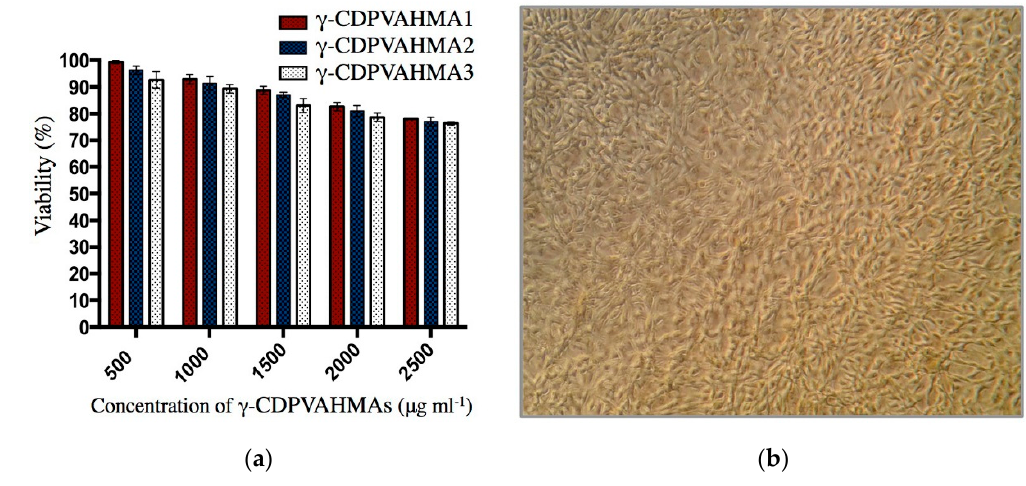
Figure 13. ( a ) Ratio (%) of cell viability, acquired from the MTT assay of the L929 fibroblast cells with respect to a negative control (without formulations); and ( b ) photograph of fibroblast cells cocultured with 2500 μ g mL − 1 of γ -CDPVAHMA3 (magnification 100×).